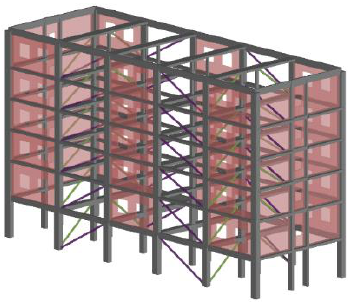
Figure 18. RP3 principal structure.